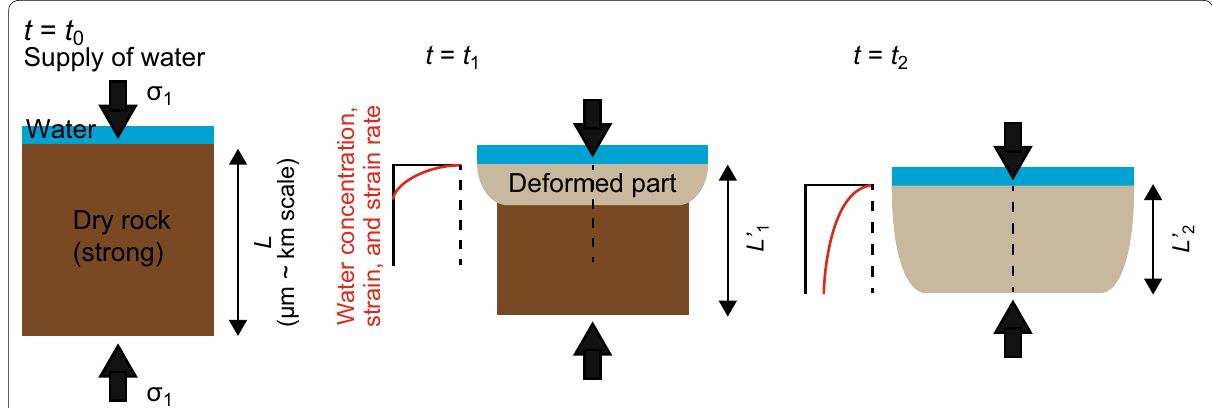
Fig. 13 Schematic image of water diffusion into a rock mass and the development of water‑diffusion‑controlled deformation. Profiles of the water concentration, strain, and strain rate (shown by red solid lines) for regions of non‑deformed dry rock mass and shortened rock mass by water diffu‑ sion (shown by dashed lines) at t t 1 and t 2 . See details in the text =